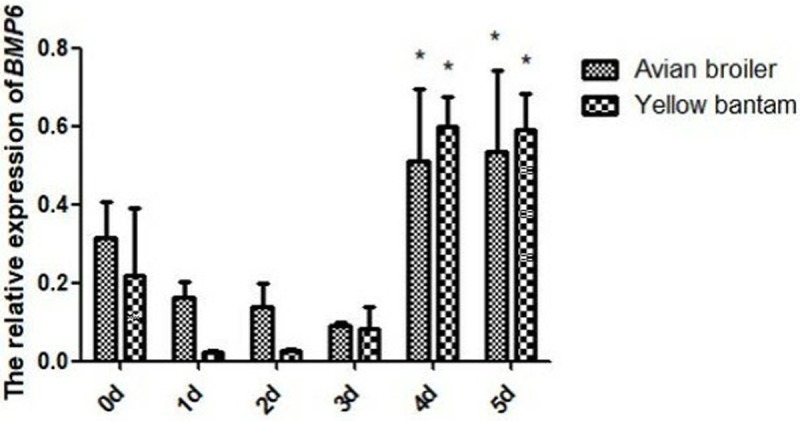
The expression of BMP6 gene was consistent with the growth curves at different days.All values are presented as the means ± SEM (n = 3). (*) represents statistical significance (P < 0.05).